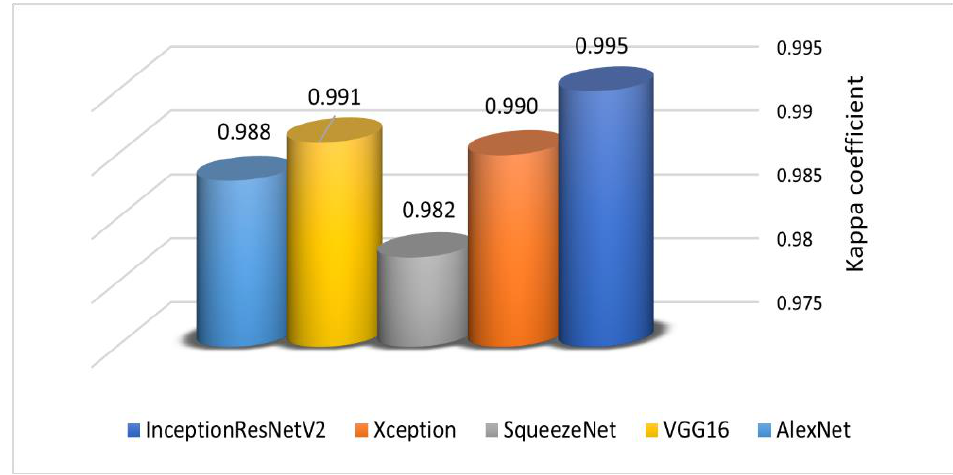
Table 5. The number of images for the training and testing process for each class.